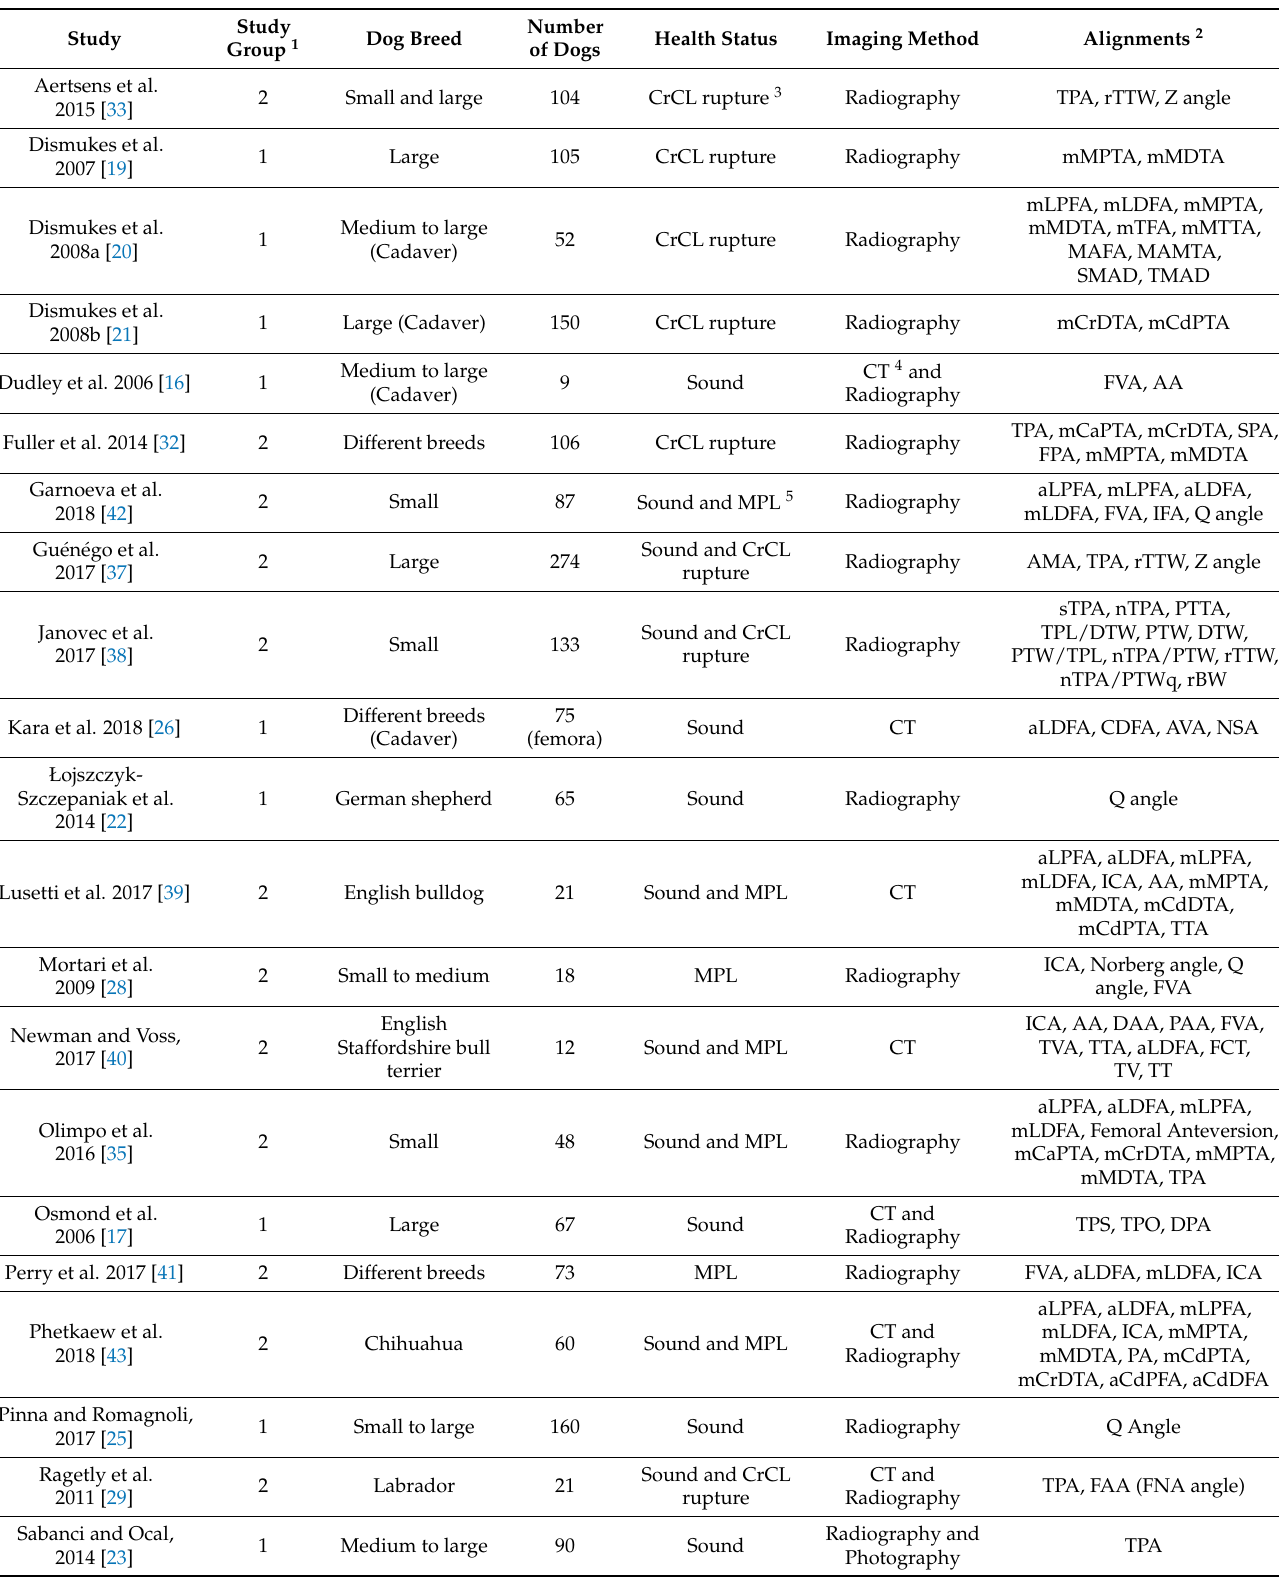
Table 1. Overview of the studies included in the systematic